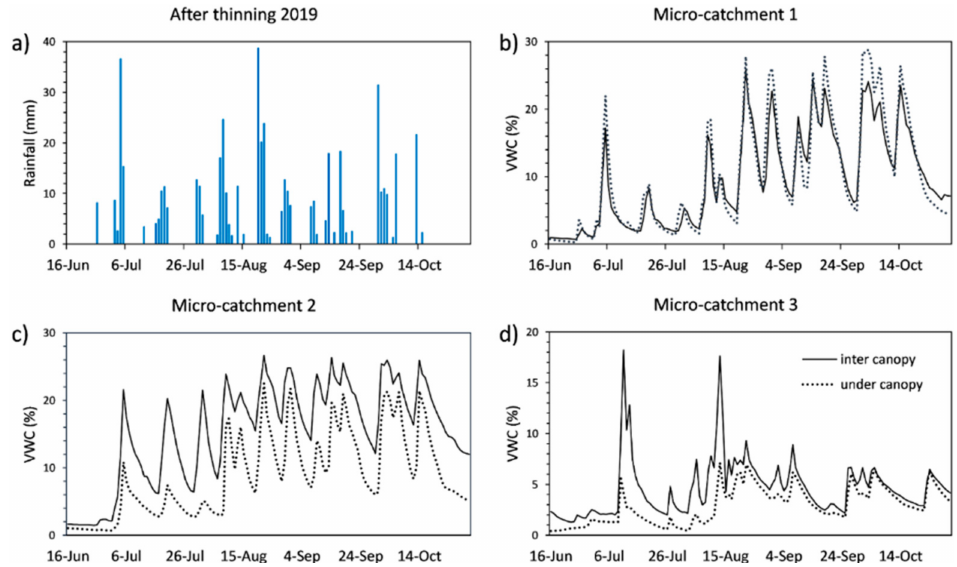
Figure 11. ( a ) Rainfall after thinning (2019); ( b – d ) Mean daily soil moisture inter canopy and under canopy during the entire study period for micro-catchment 1, 2, and 3, respectively.